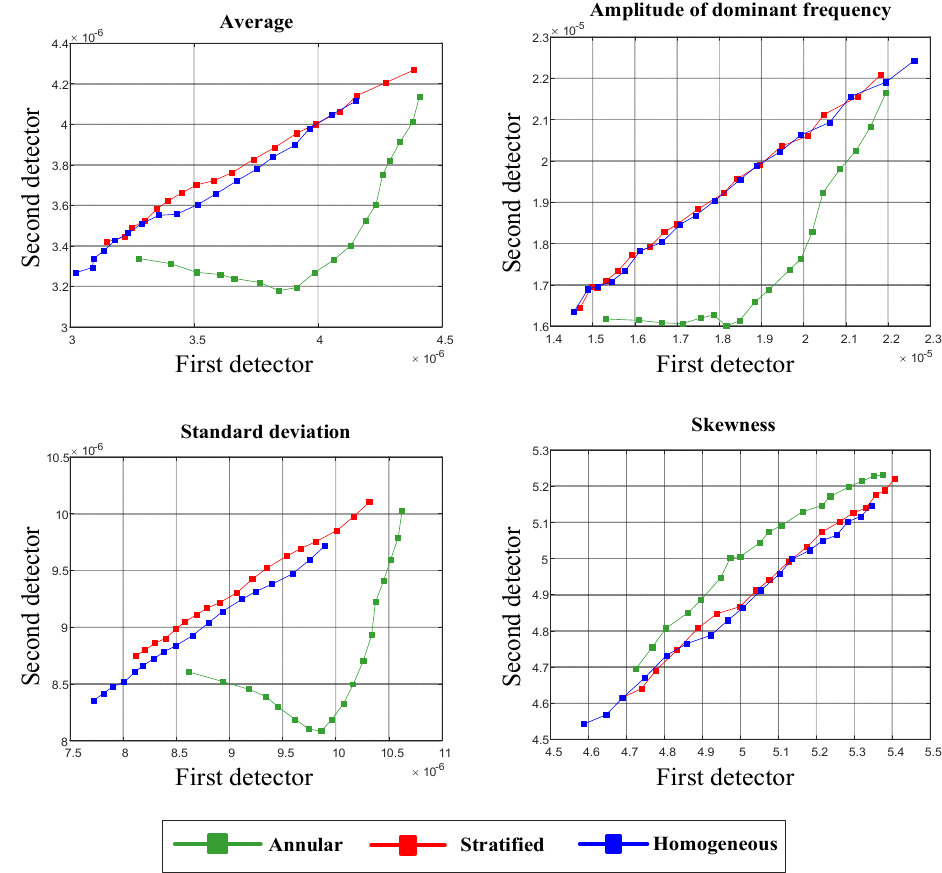
Figure 8. The extracted features from both detectors.